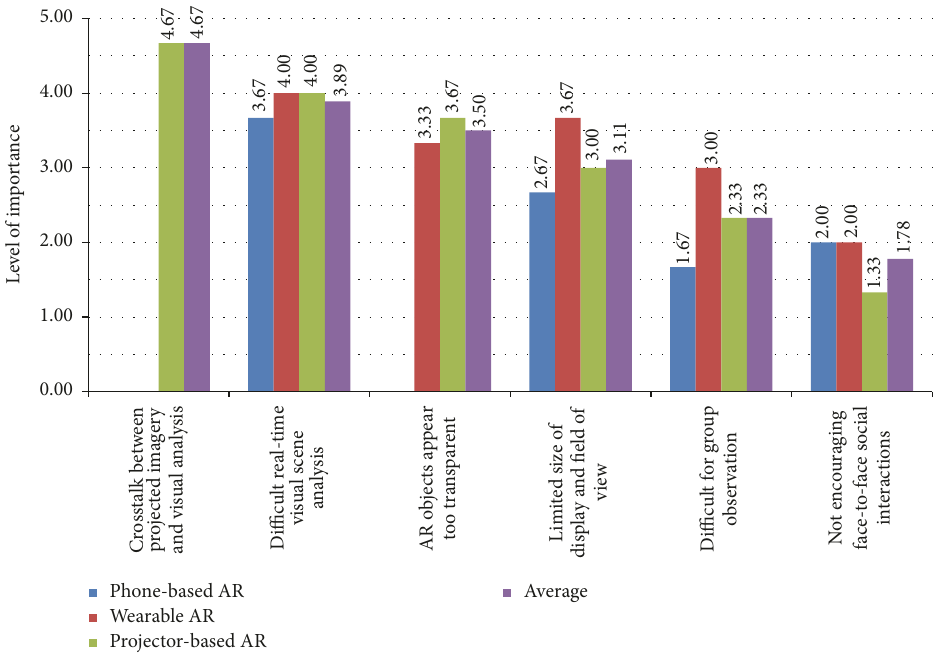
Figure 7: Conclusion of the semiquantitative results in Table 4. The six problems are sorted and visualized by their average rating values from the highest (leftmost) to the lowest (rightmost).